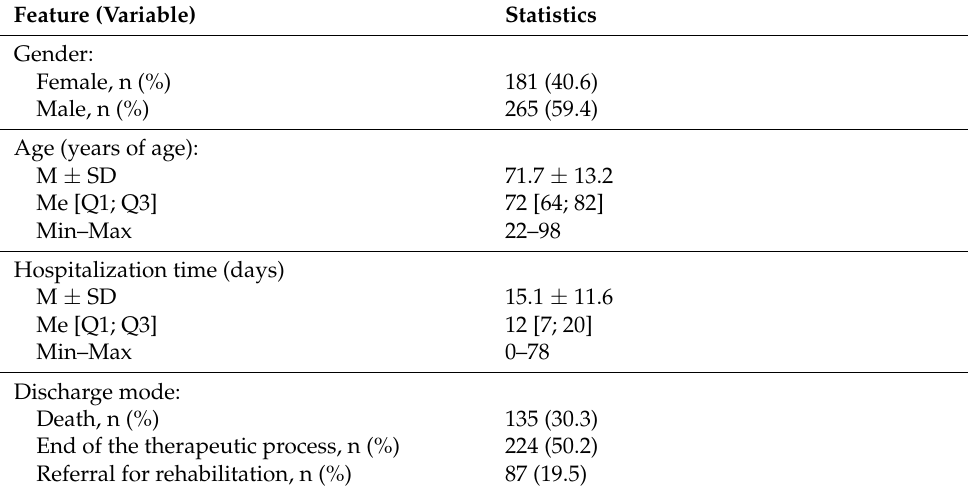
Table 1. Characteristics of 446 participants.